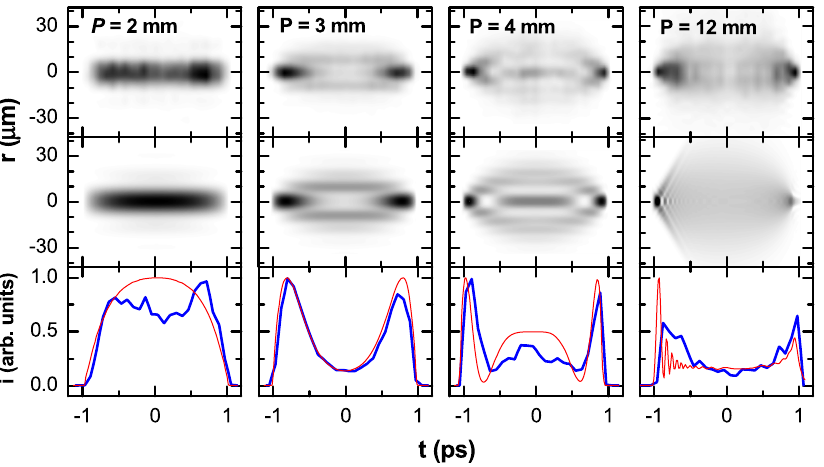
FIG. 11. (Color) Measured (top row) and simulated (middle row) spatiotemporal intensity distribution with different iris radius P using the experiment condition. The bottom row shows a comparison of the intensity at r ¼ 0 extracted from the top and middle rows (measured: bold lines; simulated: thin